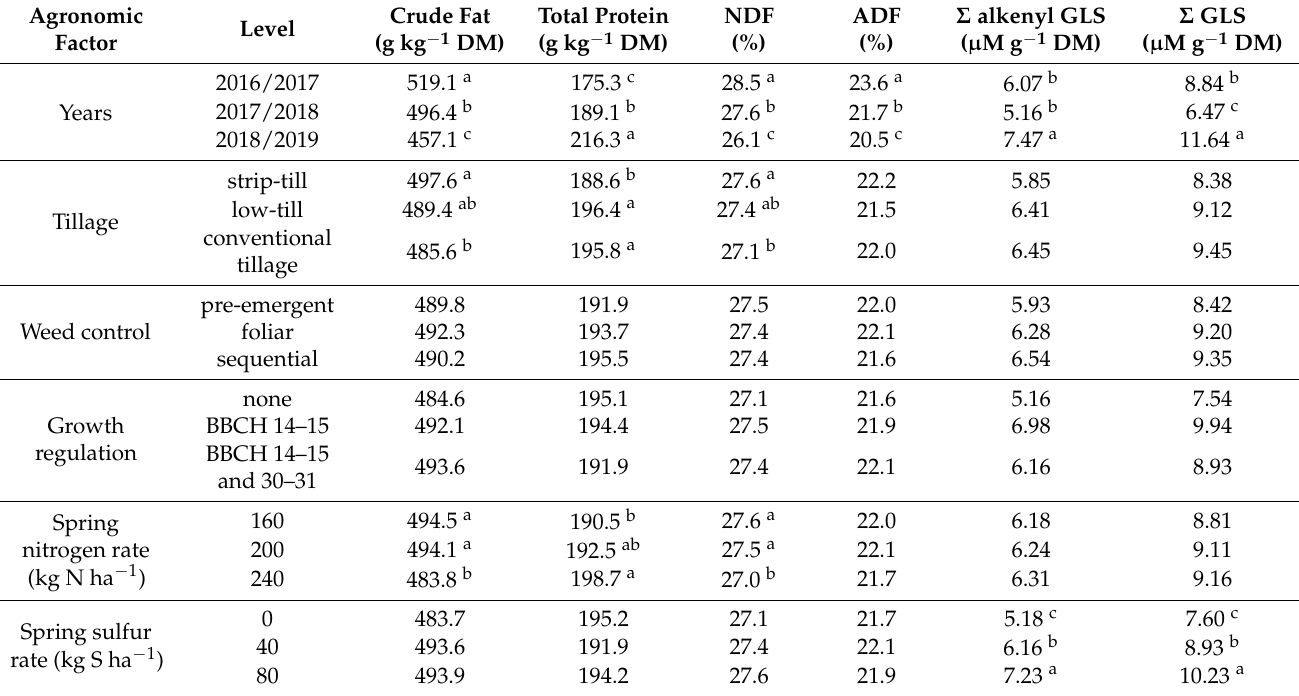
Table 3. Nutritional value of WOSR seeds (main factors).